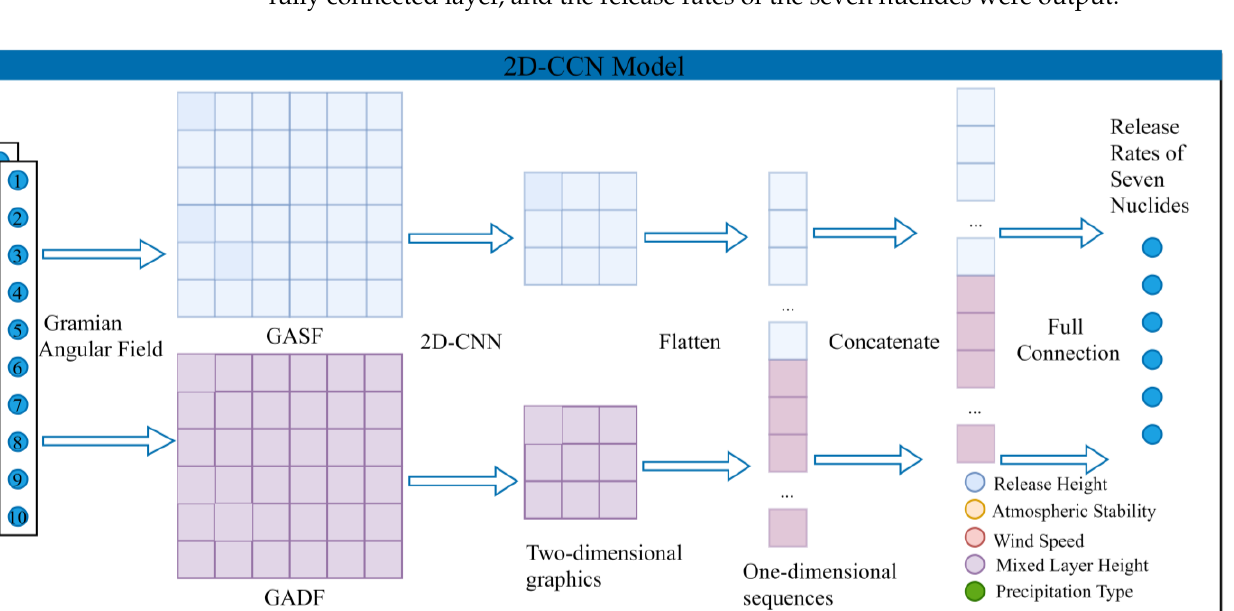
Figure 4. The process of convolutional sampling.